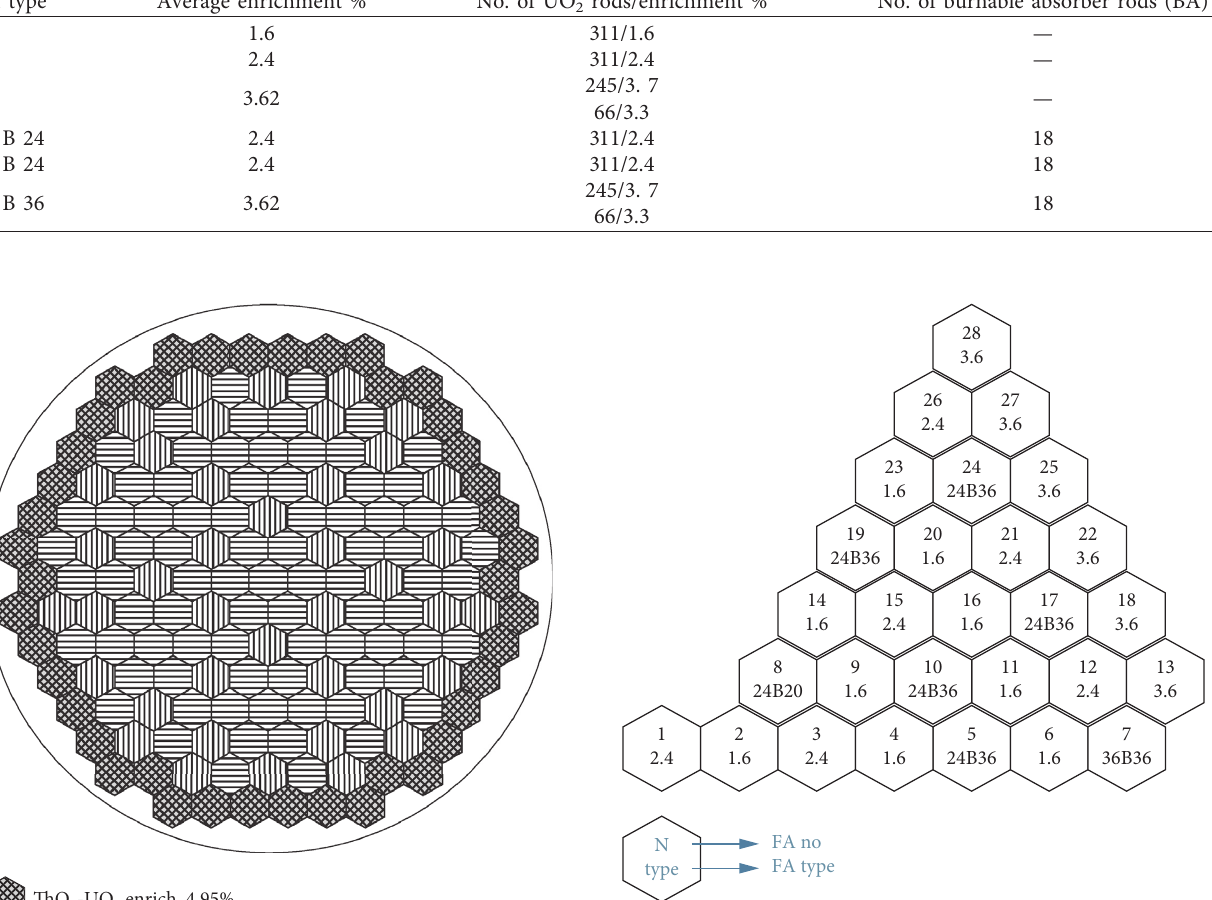
Figure 3: The VVER-1000 one-six core.